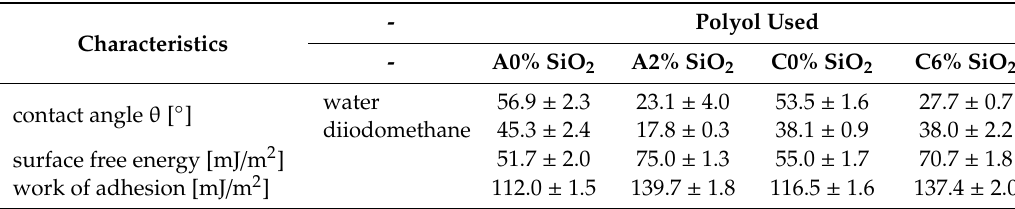
Table 4. Wetting, surface energy and work of adhesion of the studied PURs.